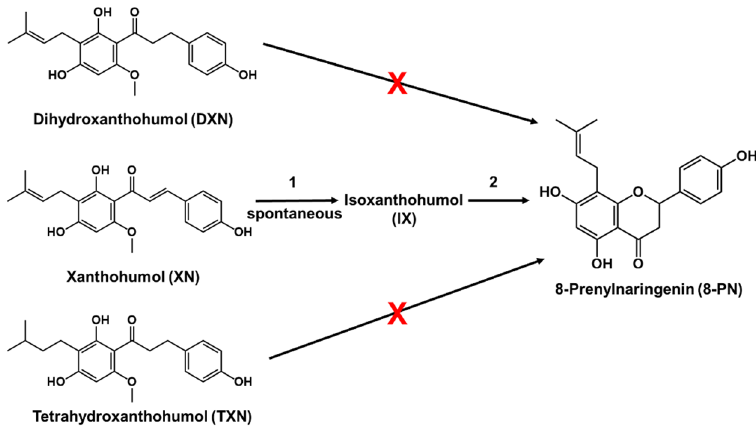
Figure 1. Structural comparison of dihydroxanthohumol (DXN), tetrahydroxanthohumol (TXN), xanthohumol (XN), and 8-prenylnaringenin (8-PN). Xanthohumol is converted to 8-prenylnaringenin in a two-step process. In step 1, xanthohumol spontaneously isomerizes to isoxanthohumol (IX). In step 2, isoxanthohumol is converted to 8-prenylnaringenin by the gut microbiome, or cytochrome P450 enzymes of the host [10,18]. XN can be converted into DXN by gut microbiota [19]. 8-PN formation is not possible with DXN or TXN. Figure adapted from [3].